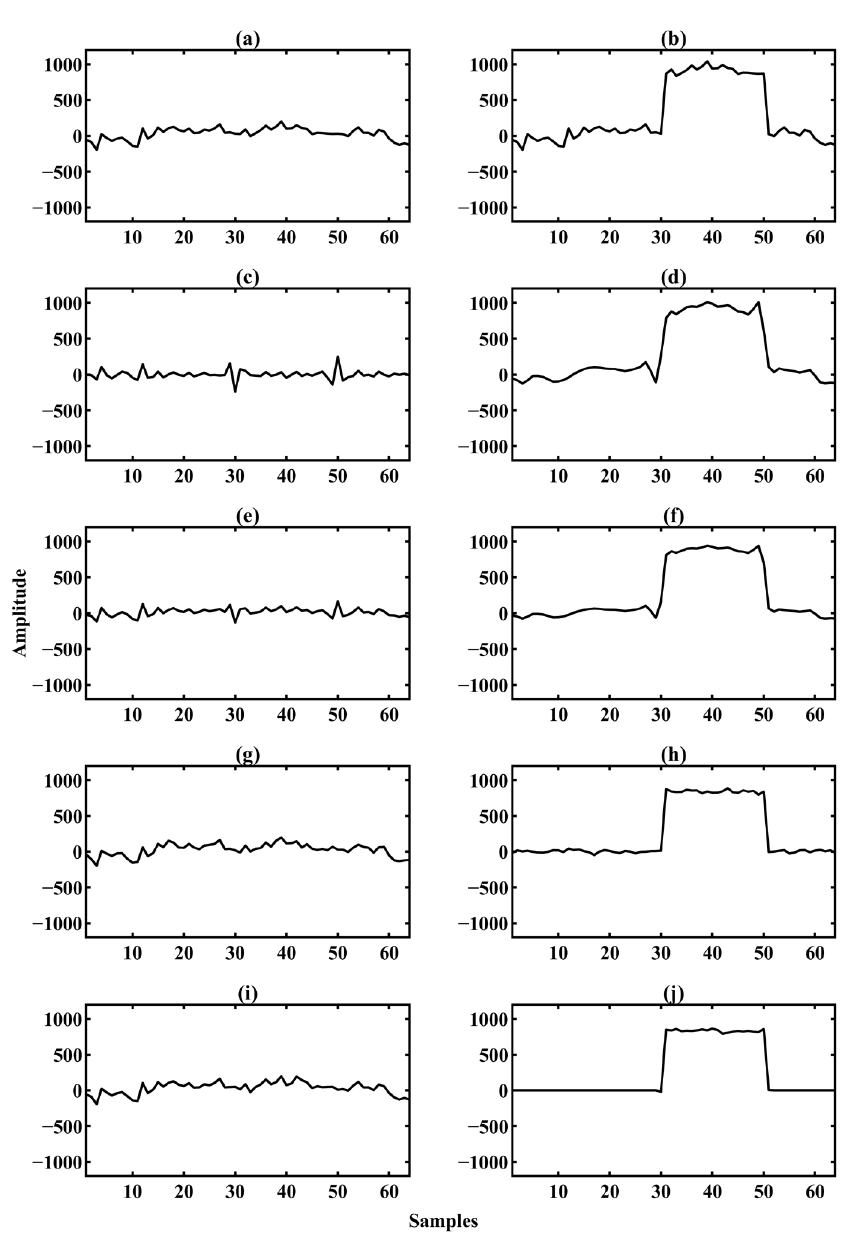
Figure 10. A denoising sample in validation datasets. ( a ) Noise-free and ( b ) Noise data. The denoising results of ( c ) the wavelet, ( e ) the dictionary learning, ( g ) the ResNet without identification and ( i ) our approach. The difference between the denoising results of ( d ) the wavelet, ( f ) the dictionary learning, ( h ) the ResNet without identification and ( j ) our approach with noise data. Table 3. The validation dataset loss and the training running time with different window sizes.